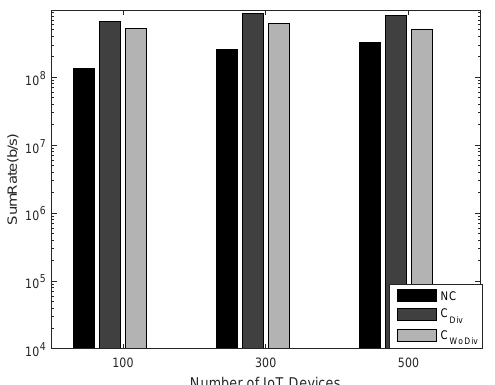
Figure 13. Sum-rate with respect to different number of total devices, with 10 relays and minimum device data rate of 10 kbps.